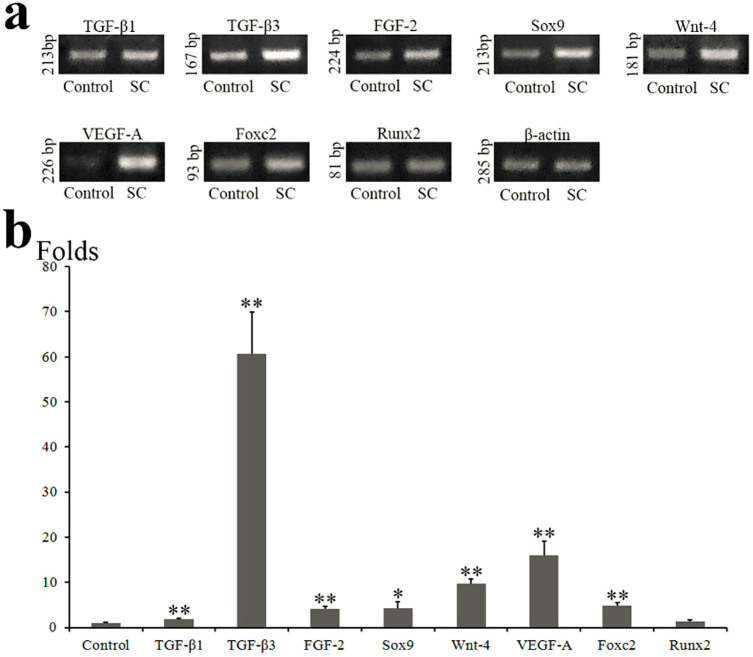
RT-PCR (a) and semi-quantitative evaluation (b) for analyzing the genes expressions in control and SC synovium.*P < 0.05, **P < 0.01 with respect to the control. Semi-quantitative values are presented as mean ± standard deviation of target gene/β-actin. The assay was performed in triplicate under the same experiment conditions. Full-length gels are presented in Supplementary Figure 1.